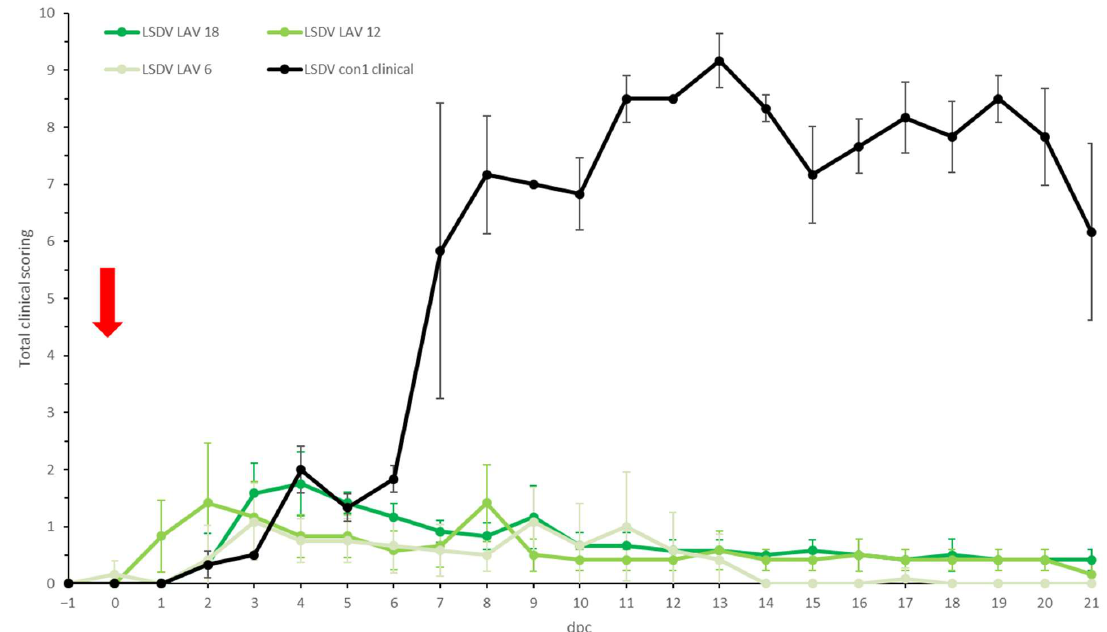
Figure 3. Averaged total clinical score of the LSDV LAV groups after challenge. For comparative purposes: the average of the clinical animals of control group LSDV con1 was added. The red arrow indicates the moment of challenge, and standard deviation is shown as error bars.